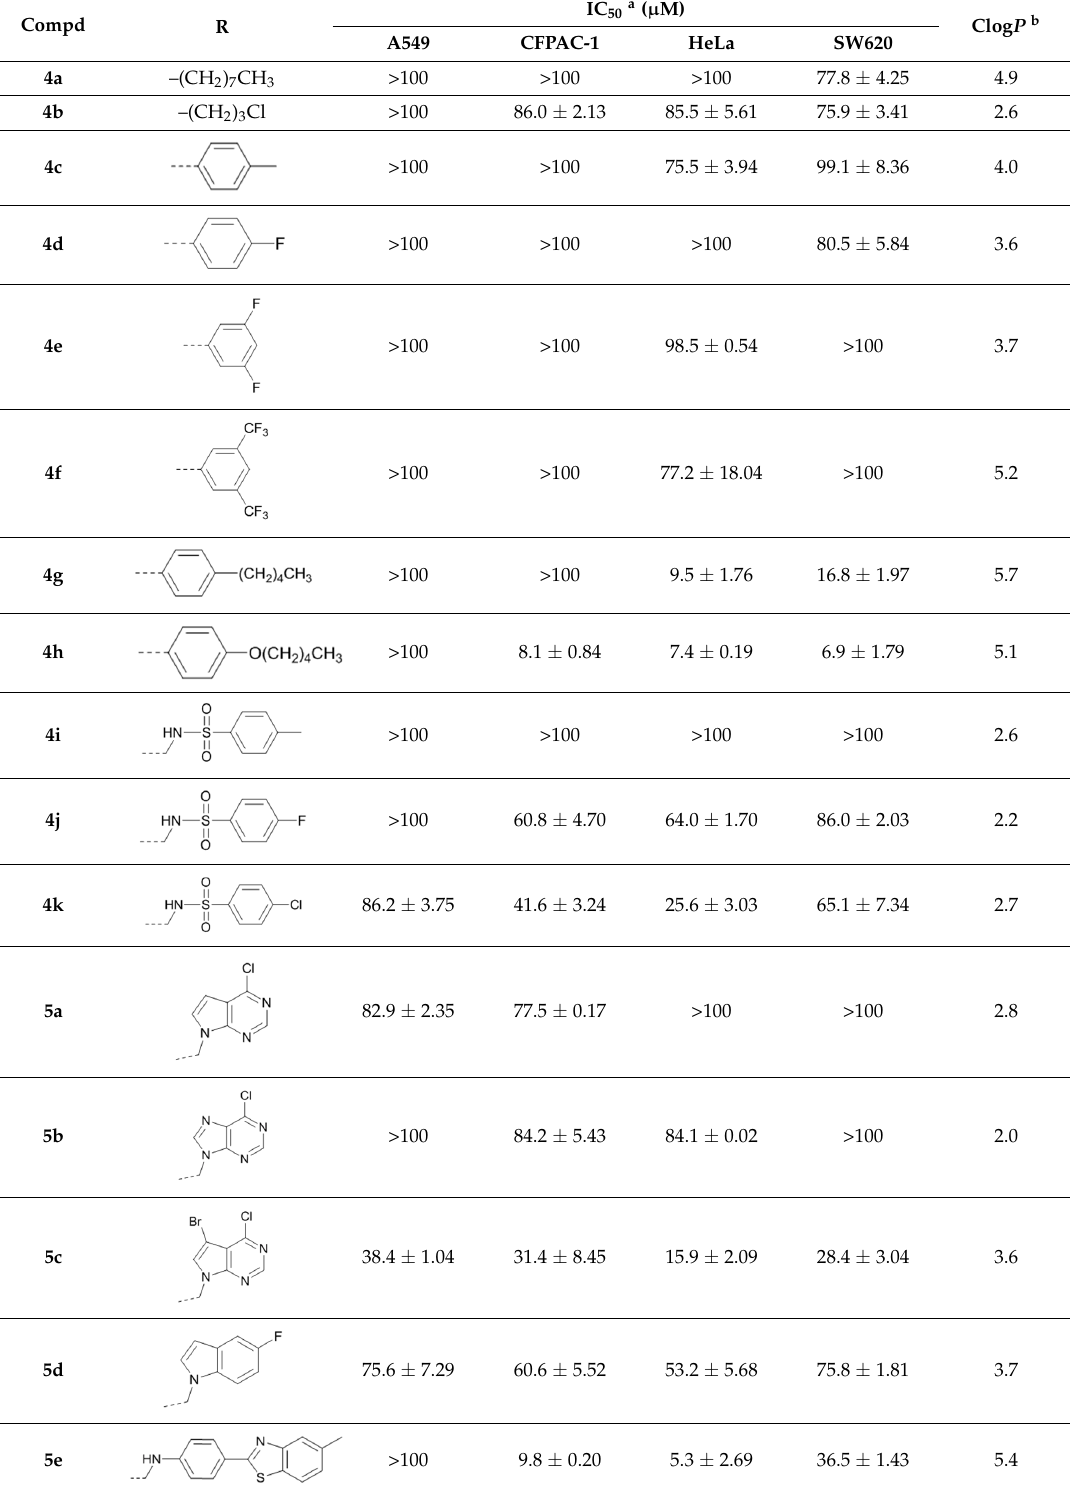
Table 1. In vitro growth inhibitory effects of synthesized compounds on selected tumor cell lines.